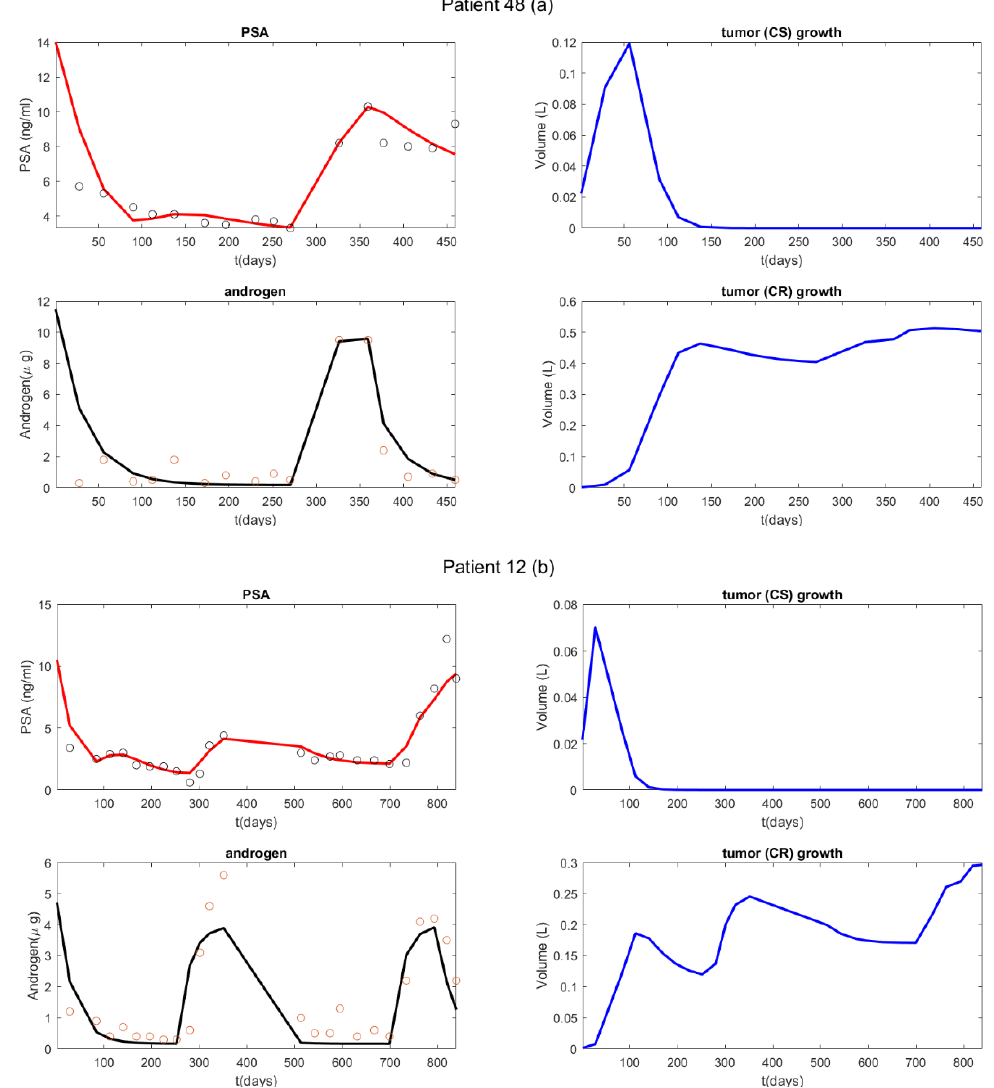
Figure 2. Model validation: Best-fit model solutions to the dynamics of serum androgen and PSA levels. Circles represent patient measurements, and the solid lines are solutions of model (model equation number). ‘CS’ = castration susceptible tumor cell population; ‘CR’ = castration-resistant population. Panel ( a ) was produced by a short dataset 1.5 cycles long, and panel ( b ) by a dataset 2.5 cycles long.